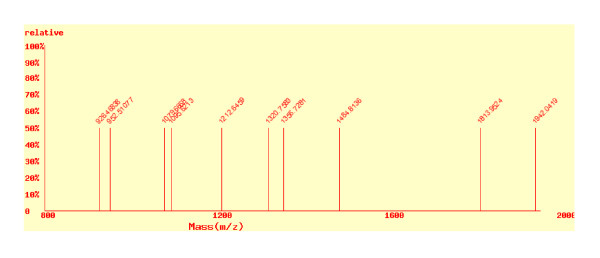
PMF map of monoisotopic peak list. Through the PHP scripts in our web sever, the mimic PMF map could be displayed in the client browser. As shown in the PMF map of glutathione transferase omega 1-1, all monoisotopic peaks could be displayed and used to compare with the user's PMF map.